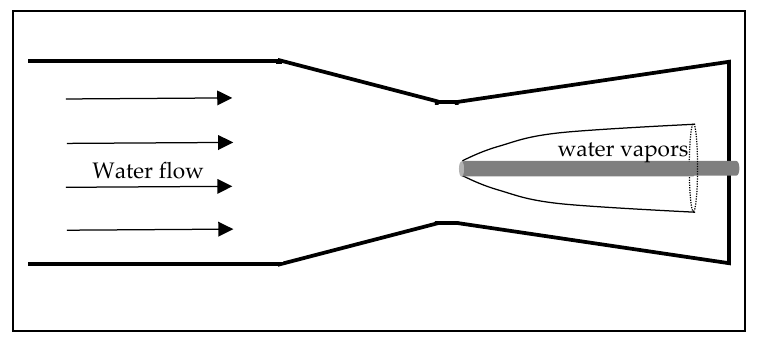
Figure 1. A scheme of the physical problem.